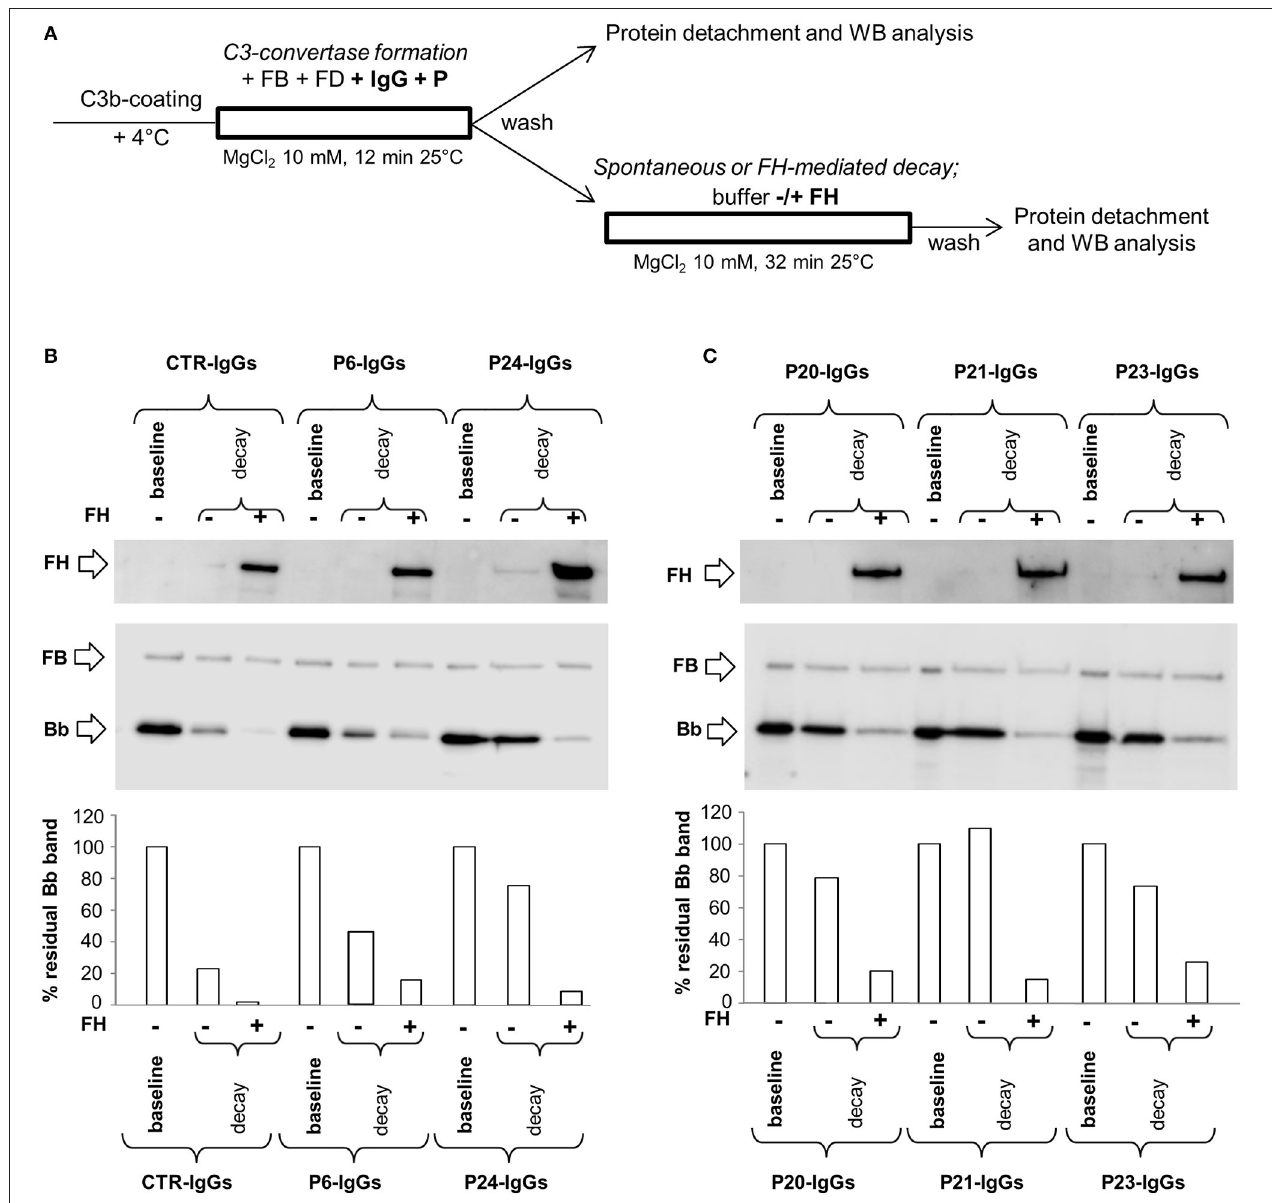
FIGURE 5 | Effect of properdin on C3 convertase-stabilizing activity of C3NeF IgGs. (A) Experimental design (protocol 3). (B,C) Representative images of the assay. C3bBb(Mg 2 + ) complexes were formed by incubating at 25 ◦ C for 12min C3b-coated wells with 1,000ng/ml FB, 10ng/ml FD, 100 µ g/ml IgGs from patients or healthy controls and 10mM MgCl 2 in the presence of 500ng/ml Properdin (P) (baseline). In additional wells after washing, spontaneous or FH-mediated decay of the formed complexes was monitored by further incubation for 32min at 25 ◦ C with buffer alone (decay –) or buffer added with 2,640ng/ml FH (decay + ), respectively. The percentage of residual Bb band was calculated as the ratio of the densities (in Pixel 2 ) of each Bb band (visualized by an anti-FB antibody) after decay and the corresponding baseline Bb band density before decay x 100, and results are reported in the bottom graphs. The membranes were then incubated with an